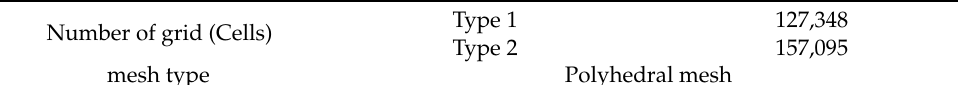
Figure 13. Computational domain and mesh generation of the two types of CO 2 methanation reactors. Table 4. Mesh constitution of reactor type. Table 4. Mesh constitution of reactor